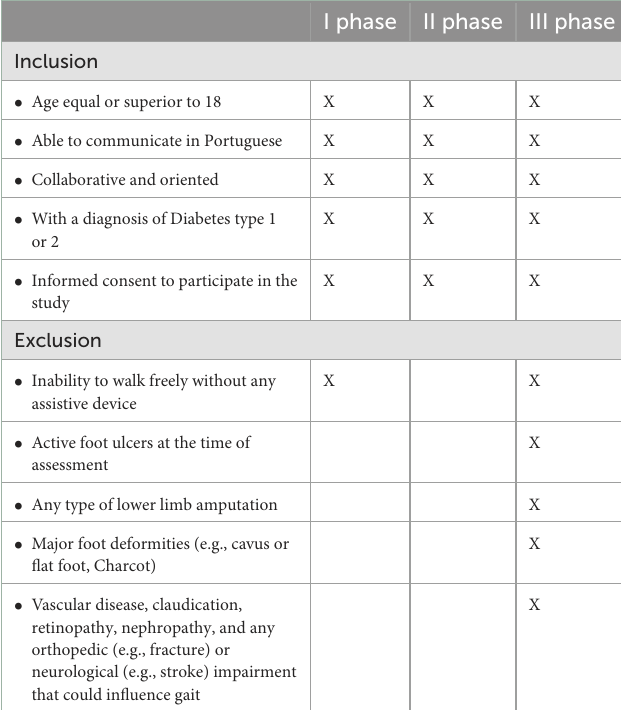
TABLE 1 Eligibility criteria for participants.